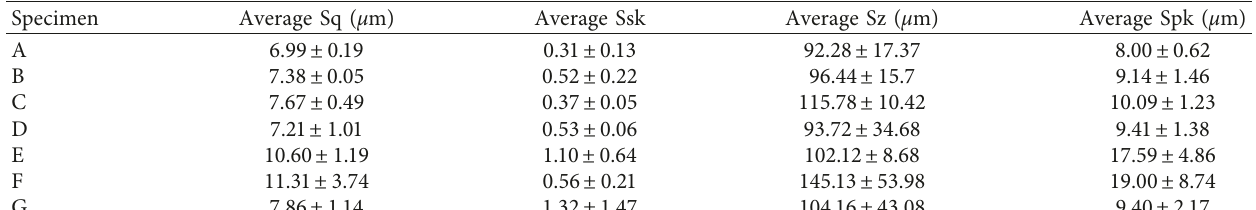
Table 2: Surface profilometry results.